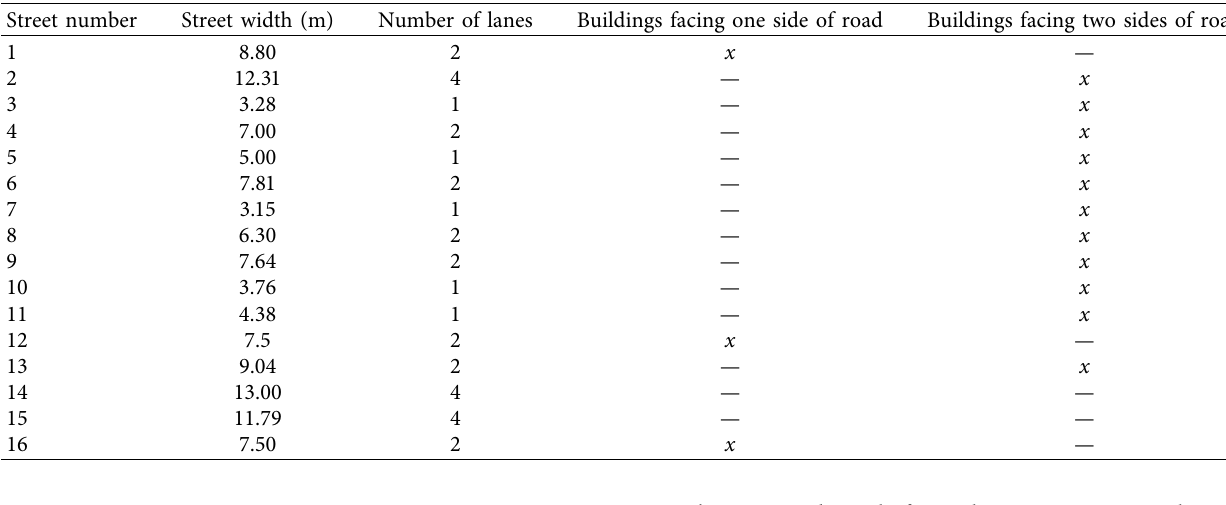
Figure 1: Map for categorized buildings and streets under investigation. Table 1: Description of road network main